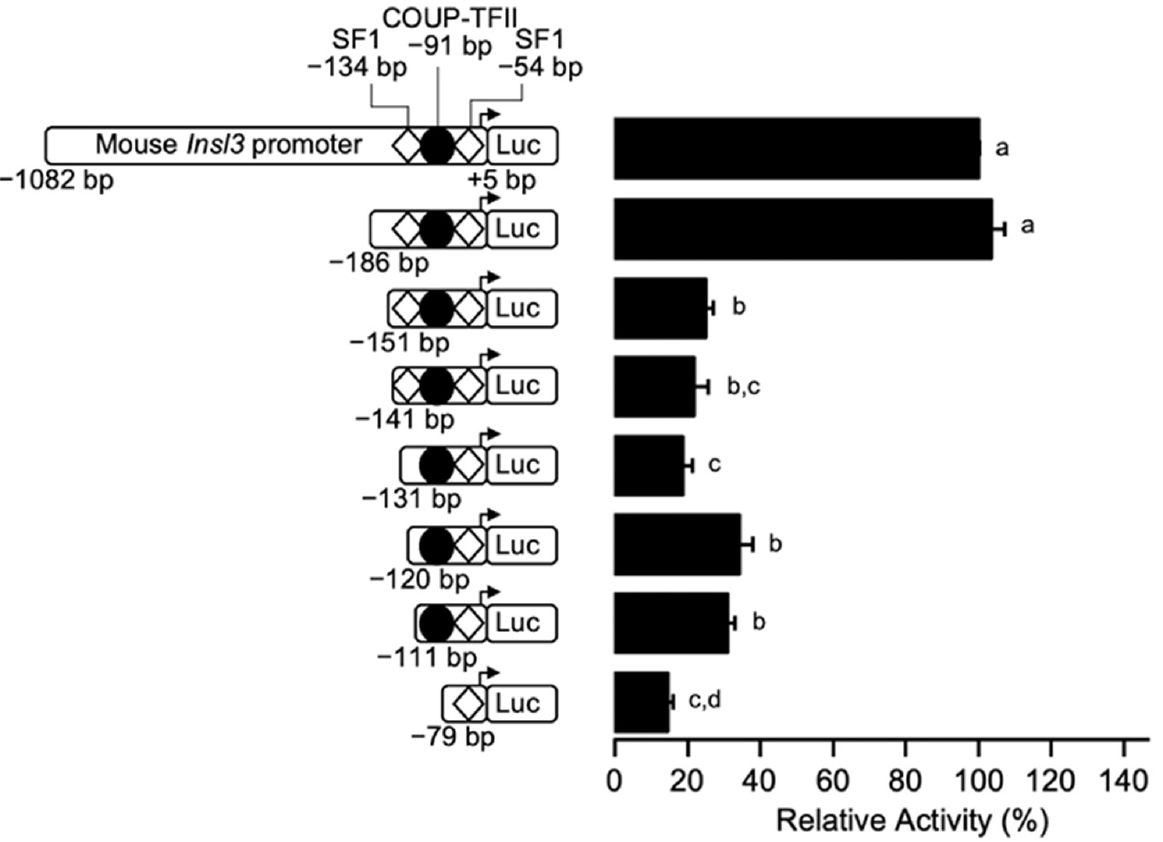
Figure 2. The region between − 186 and − 151 bp confers 70% of mouse Insl3 promoter activity in Leydig cells. MA-10 Leydig cells were transfected with a series of fine 5’ deletion constructs of the mouse Insl3 promoter; the 5 ′ end point of each construct is indicated on the left of the graph. The position of previously identified binding sites for SF1 (white diamonds) and COUP-TFII (black circle) is indicated. Results are shown as % Relative Activity ( ± SEM) relative to the activity of the − 1132 bp reporter, which was set to 100%. Different letters indicate a statistically significant difference between groups ( p < 0.05).